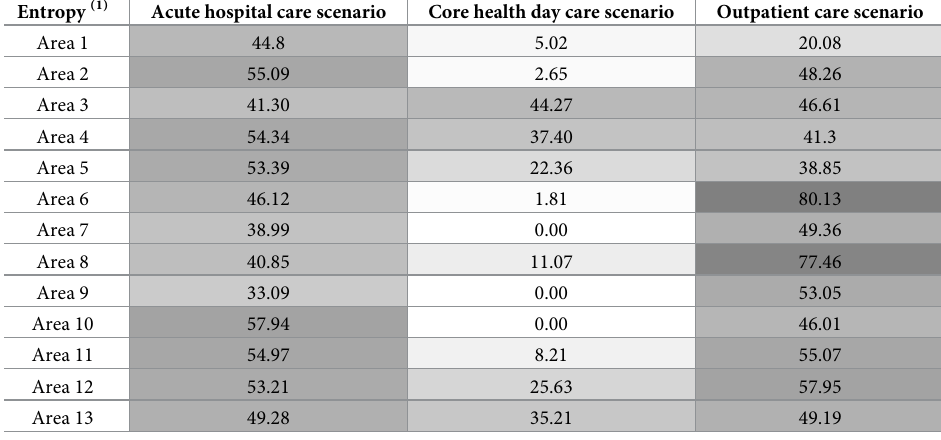
Table 5. Entropy scores. White indicates the lowest values, and dark grey indicates the highest values. Darker shading means higher entropy. Entropy